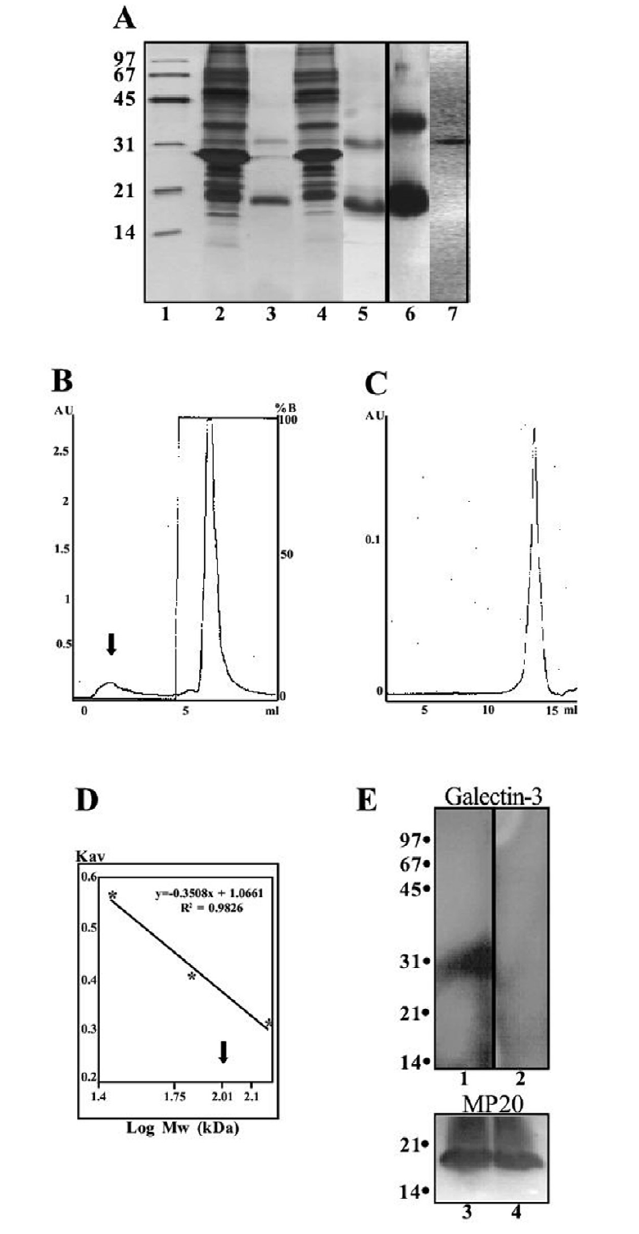
Figure 5 Purification of a native MP20/galectin-3 complex from lens membranes and role of lectin site. (A) SDS-PAGE and Western blot documentation of the purification process. Lane 1: Molecular weight markers. Lane 2 : Partially stripped lens fiber cell membranes showing both galectin-3 and enriched MP20. Lanes 3 and 4: Proteins that did not bind (including MP20 and galectin-3) and proteins that did bind to the MonoQ column, respectively. Lane 5: MP20 and galectin-3 eluted from the S-200 column. Lanes 6 and 7: Immunoblot of lane 5 identifying MP20 and galectin-3, respectively. Note that anti MP20 also recognizes dimeric MP20 that is not normally detected on stained gels. (B) Galectin-3 and MP20 did not bind to the column at pH8 (arrow). (C) Size exclusion chromatography of the complex. A single peak eluted from the S-200 column at 13.8 ml. AU refers to absorbance units at 280 nm. (D) Calibration of the S-200 m column. Vo = 8 ml. MP20/galectin-3 complex has an apparent molecular mass of 102 kDa (arrow). (E) Immunoprecipitation of MP20 and galectin-3 and protein detection by Western blot- ting. Lanes 1 and 2: galectin-3 detected without and with lactose present, respectively. Note the removal of galectin-3 from the complex in the presence of lactose. Lanes 3 and 4: Equal amounts of MP20 are detected without and with lactose present,